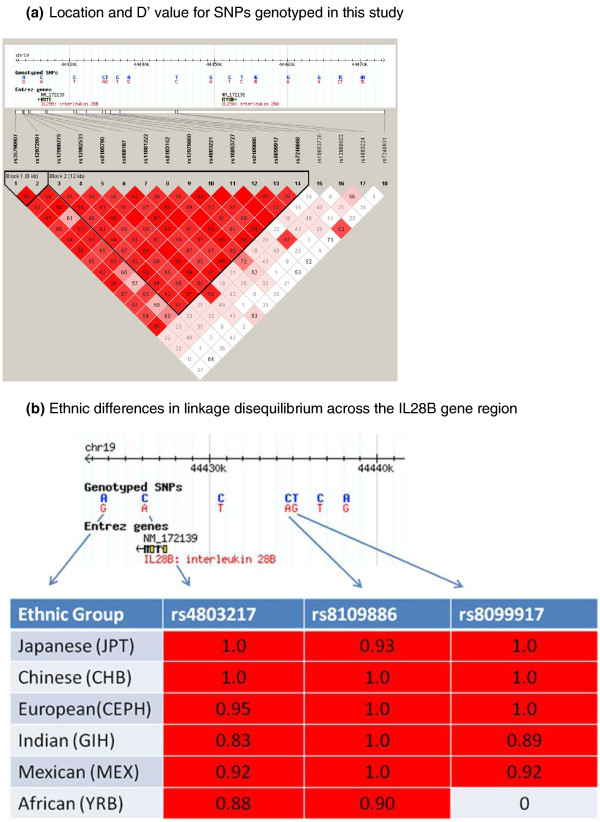
IL28B Haplotype Blocks. (a) Location and D' values for the SNPs genotyped in this study. Linkage disequilibrium blocks determined from our cohort data using Haploview. HapMap SNPs genotyped in multiple populations shown in the header map in each case. (b) Ethnic differences in linkage disequilibrium across the IL28B gene region. r2 values are for the currently available SNPs genotyped in different ethnic groups, with the designated SNPs compared to rs12980275.